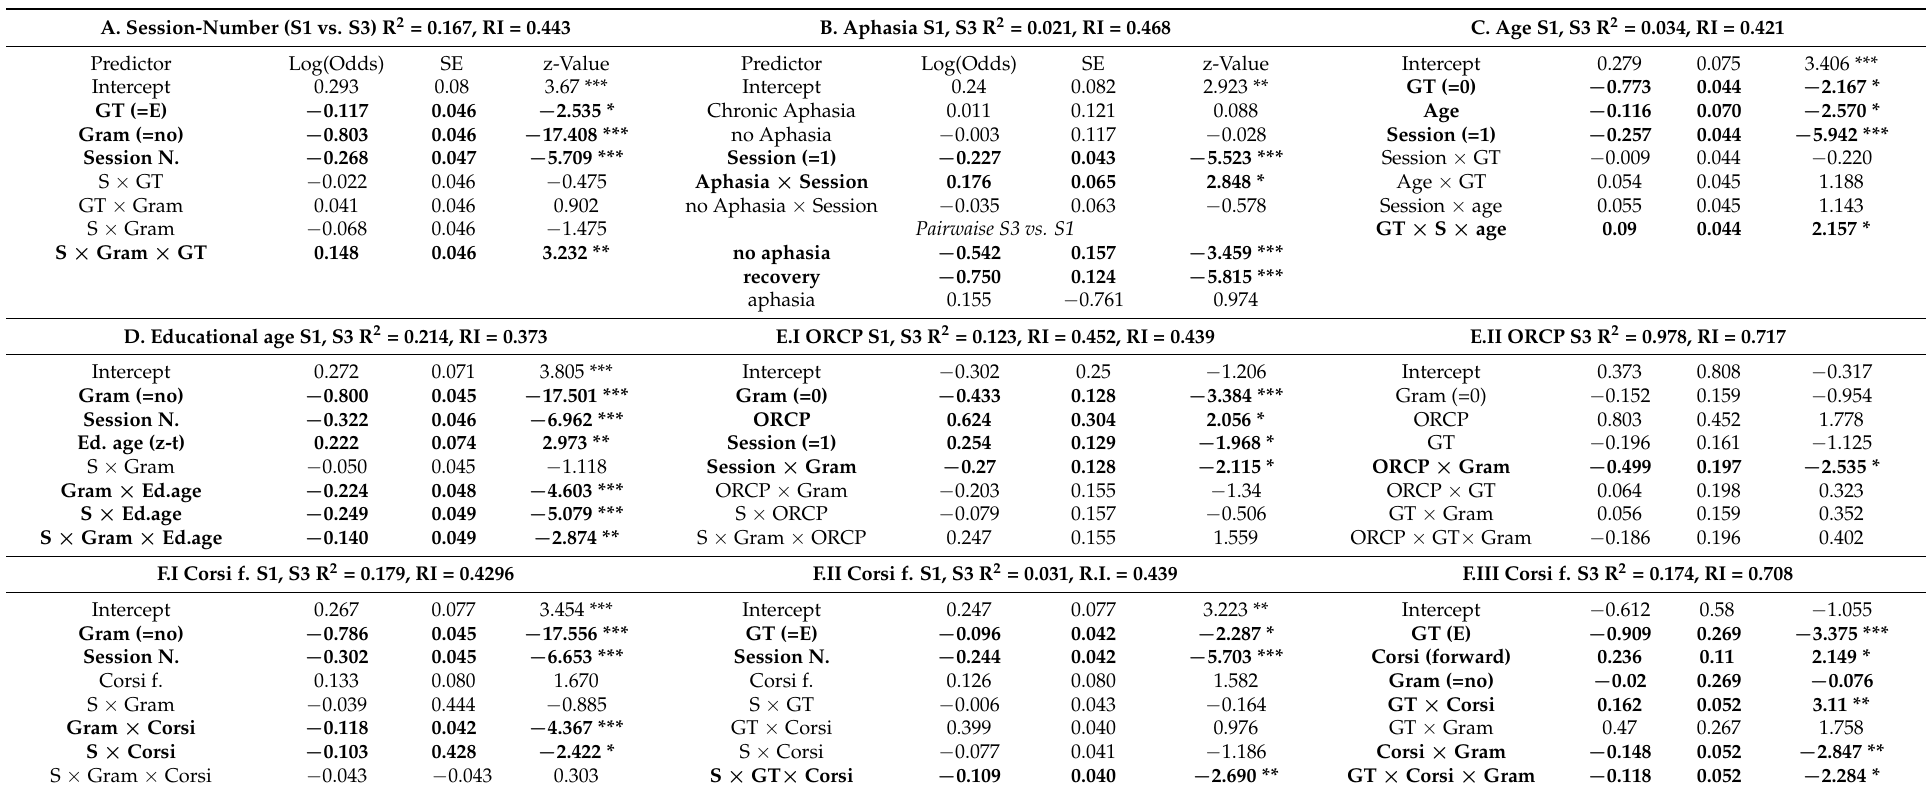
Table 4. LHSP results. Fixed effects and their interactions for all the models describing performance in